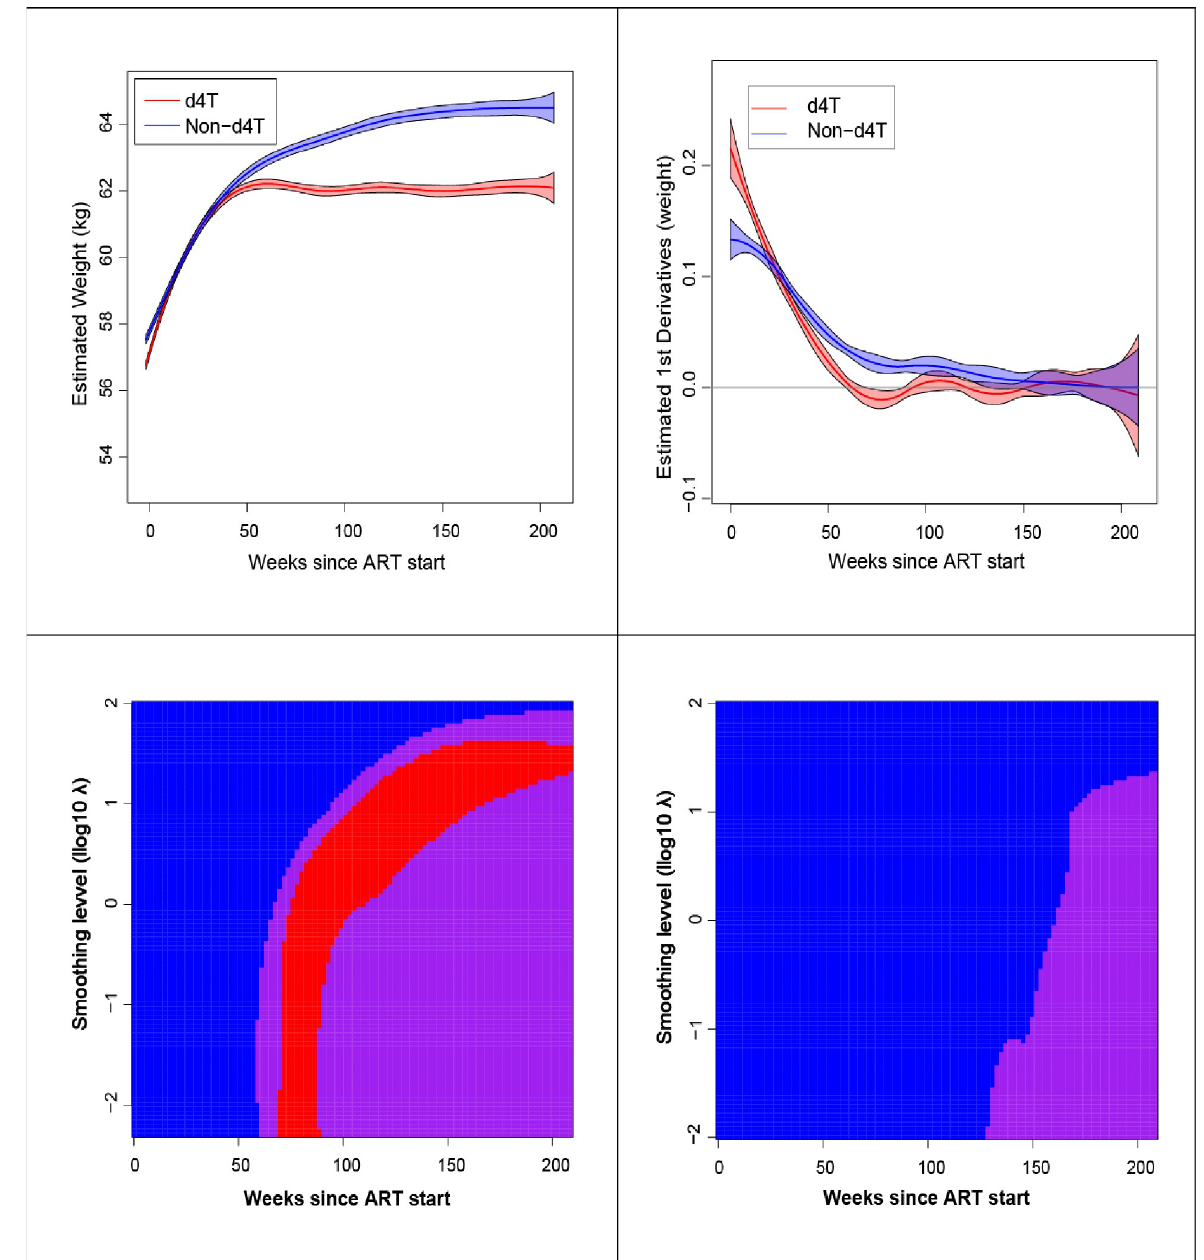
Fig 5. Southern Africa: Plots of the weight change and its first derivative (top row) and PS-SiZer Maps (bottom row), for d4T-containing and non-d4T-contiainging ART regimens (left and right column respectively). containing regimens (S1 and S2 Figs) extend past week 80, indicating that weight continues to increase past 80 weeks after initiation of ART. Analyses at the optimum smoothing level pro- duced the estimated curves of weight measurements are shown in S1 and S2 Figs and rows 2 and 3 in Table 3. For East Africa, results at the optimal smoothing levels showed that the weight in patients treated with d4T-containing regimens did not significantly increase after 52.9 weeks compared to 84.9 weeks for patients treated with non-d4T-containing regimens.